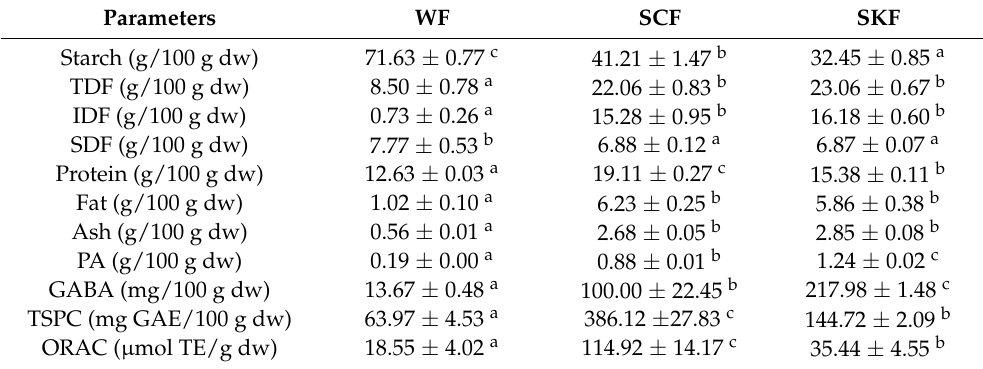
Table 1. Chemical composition (expressed as dry weight, dw) of wheat flour and sprouted pseudo- cereal